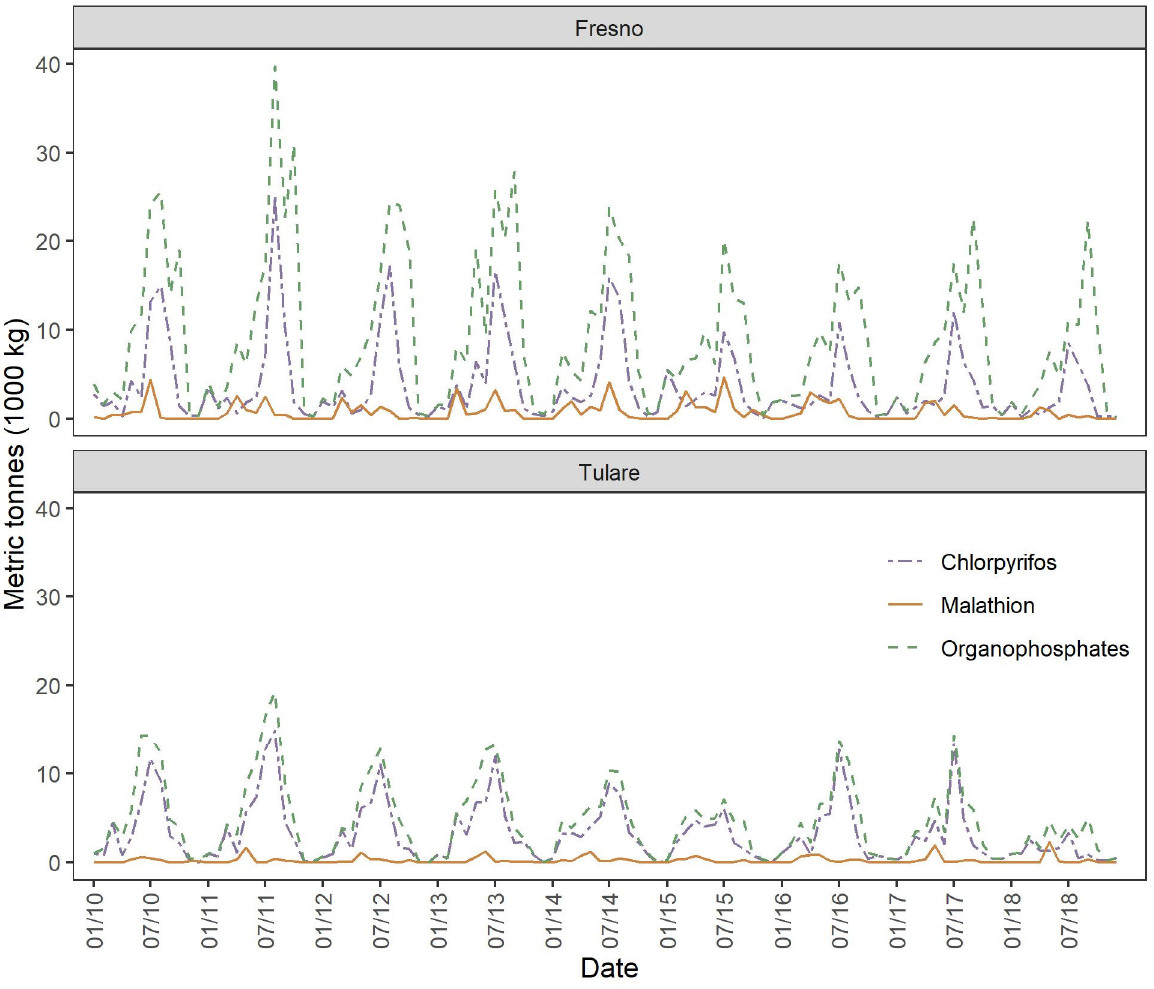
Figure 2. Annual agricultural application (in metric tonnes) by month of total organophosphates in study counties, 2010–2018. study counties,